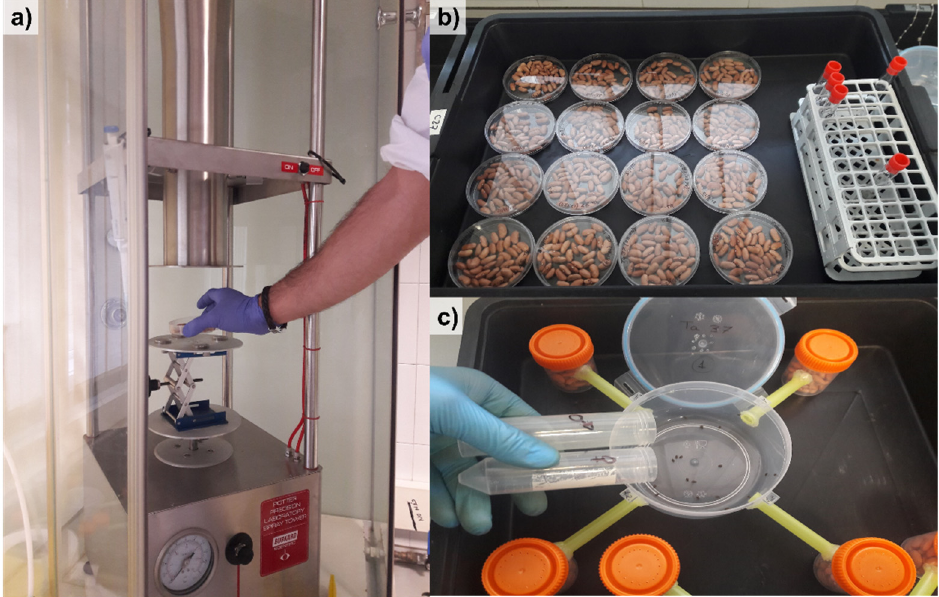
Figure 1. (a ) Potter Spray Tower; ( b ) sprayed beans in Petri dishes; ( c ) structure of plastic containers used in the